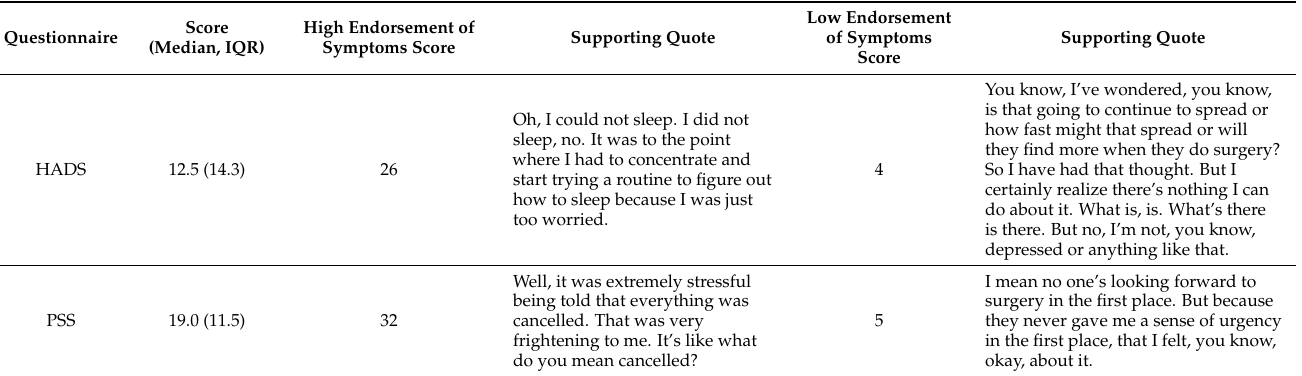
Table 3. Integration of quantitative and qualitative findings through joint